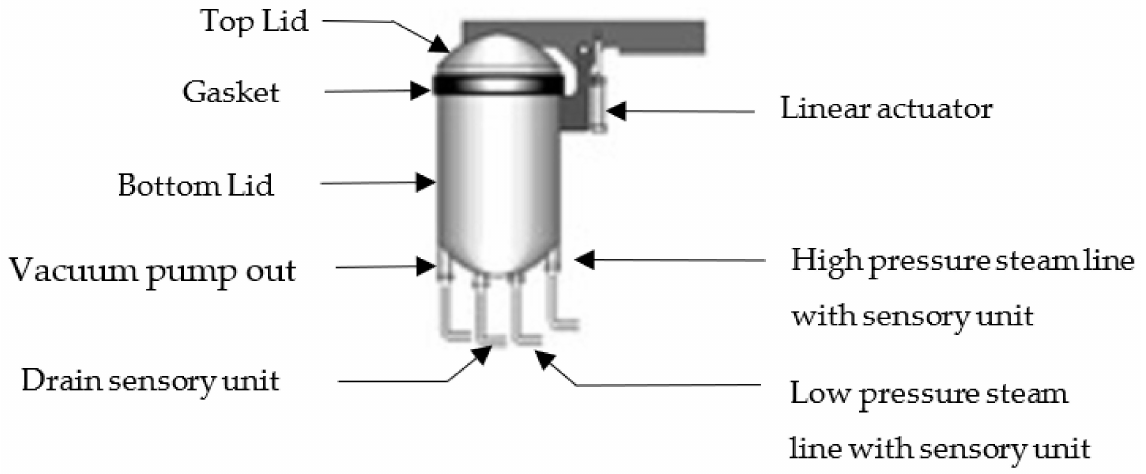
Figure 1. Curing machine (source: Fenner India Limited—South